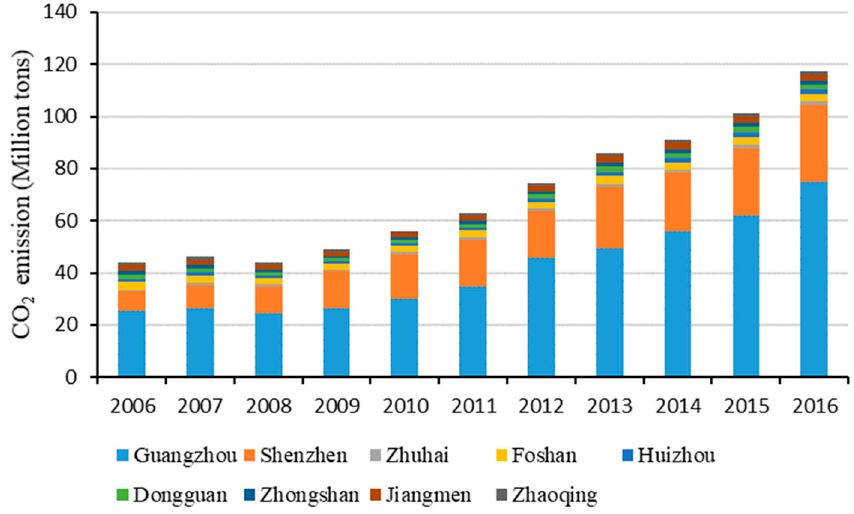
Figure 4. The CO 2 emissions from transportation of the Pearl River Delta, 2006 – 2016.